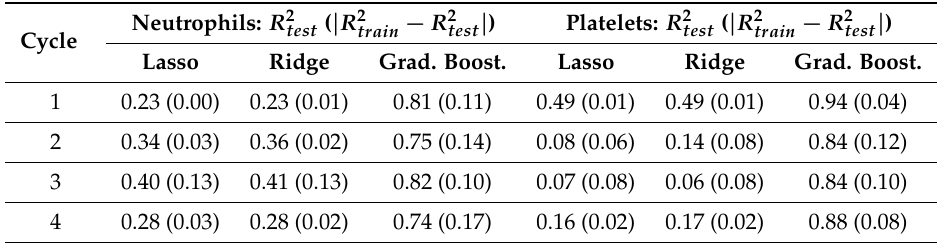
Table 3. Comparison between Lasso, Ridge and gradient boosting predictions for IVA cycles 1 to 4. The table shows the mean R 2 value for each model following a 10-fold cross validation procedure at the observation level. The value in parenthesis is the mean difference of R 2 values in the training and testing datasets (in absolute